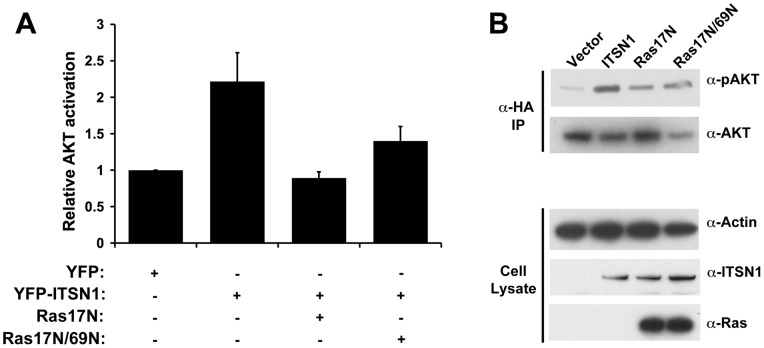
Ras is necessary for ITSN1 activation of AKT.(A) YFP-ITSN1 overexpression stimulates AKT activation as measured by levels of phospho-AKT as previously described [22]. Co-expression of Ras17N or Ras17N/69N inhibits this response. Results represent the average fold activation of AKT ± S.E.M. from at least three independent experiments. (B) Western blot analysis of AKT activation from a representative experiment. Top two panels represent Western blots of HA immunoprecipitates of cell lysates to assess AKT activation as described in the Materials and Methods section. The lower three panels indicate the level of expression of ITSN1, Ras, and actin (a loading control).